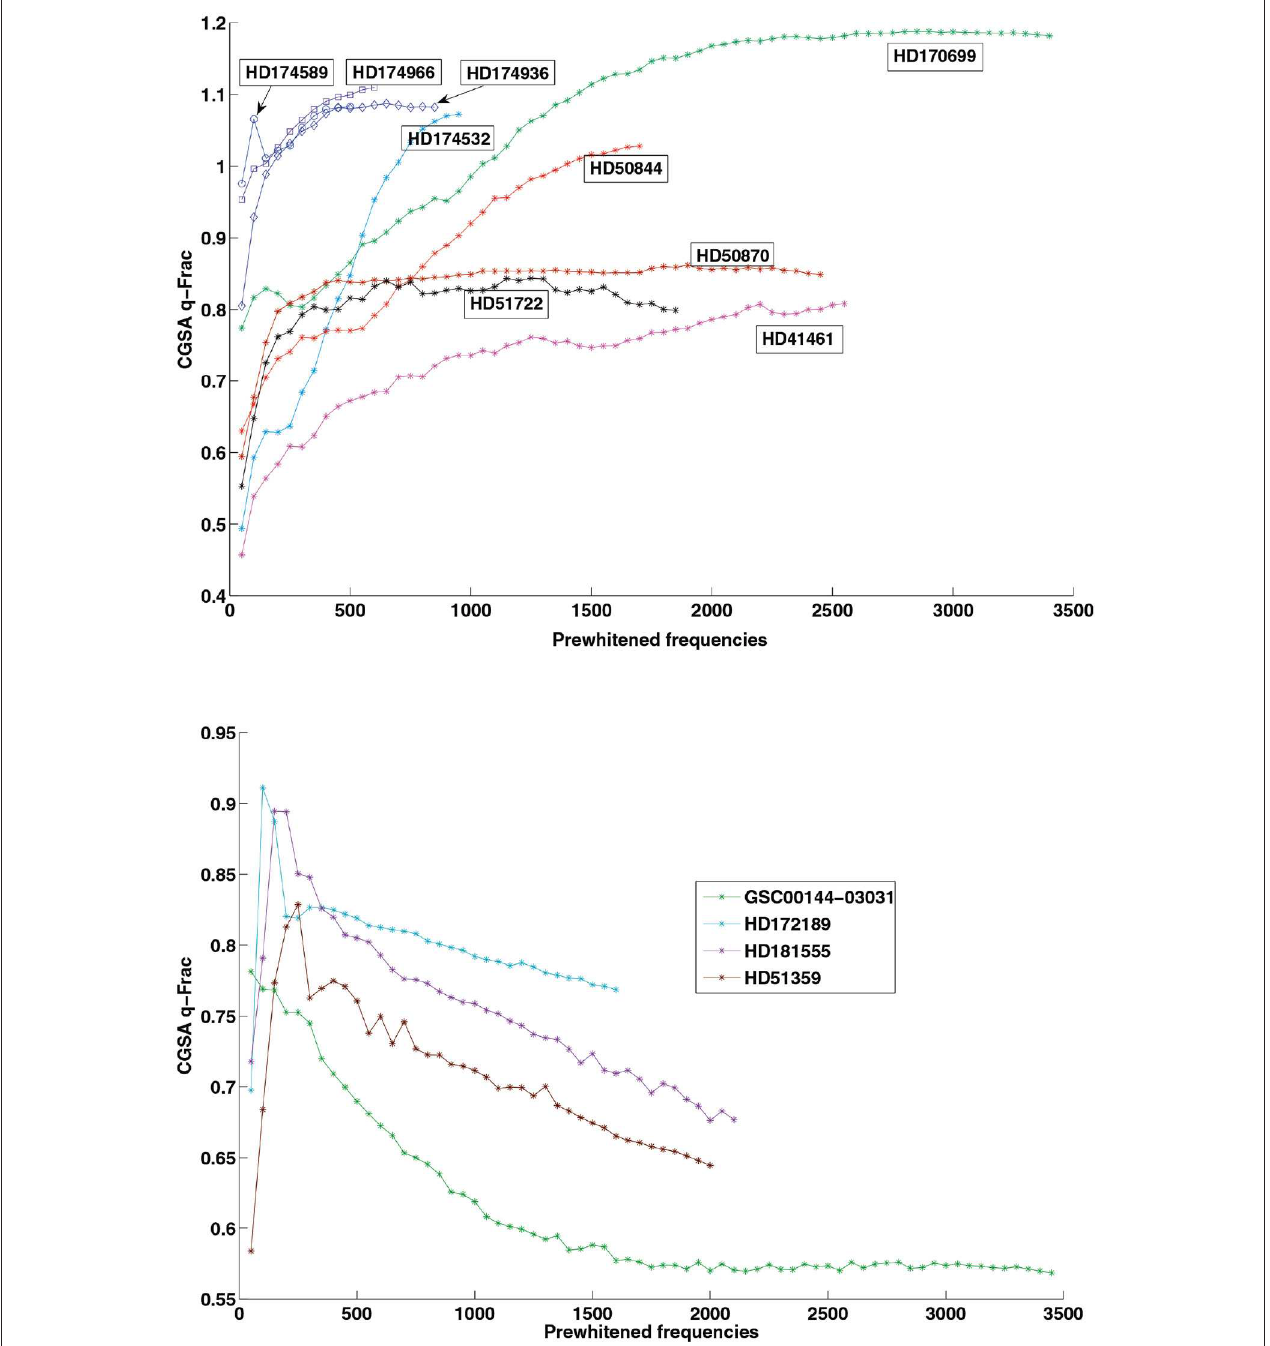
FIGURE 2 | Illustration of the variation of the fractal component of the signal as a function of the pre-whitening step for sample of well-known δ Sct stars observed with the CoRoT satellite. Points are separated by 50 pre-whitening steps. The test always starts at 0 and grows until it reaches an asymptotic behavior (Upper Panel) or a maximum (Lower Panel) close to 1. Figures from Franciscis et al.